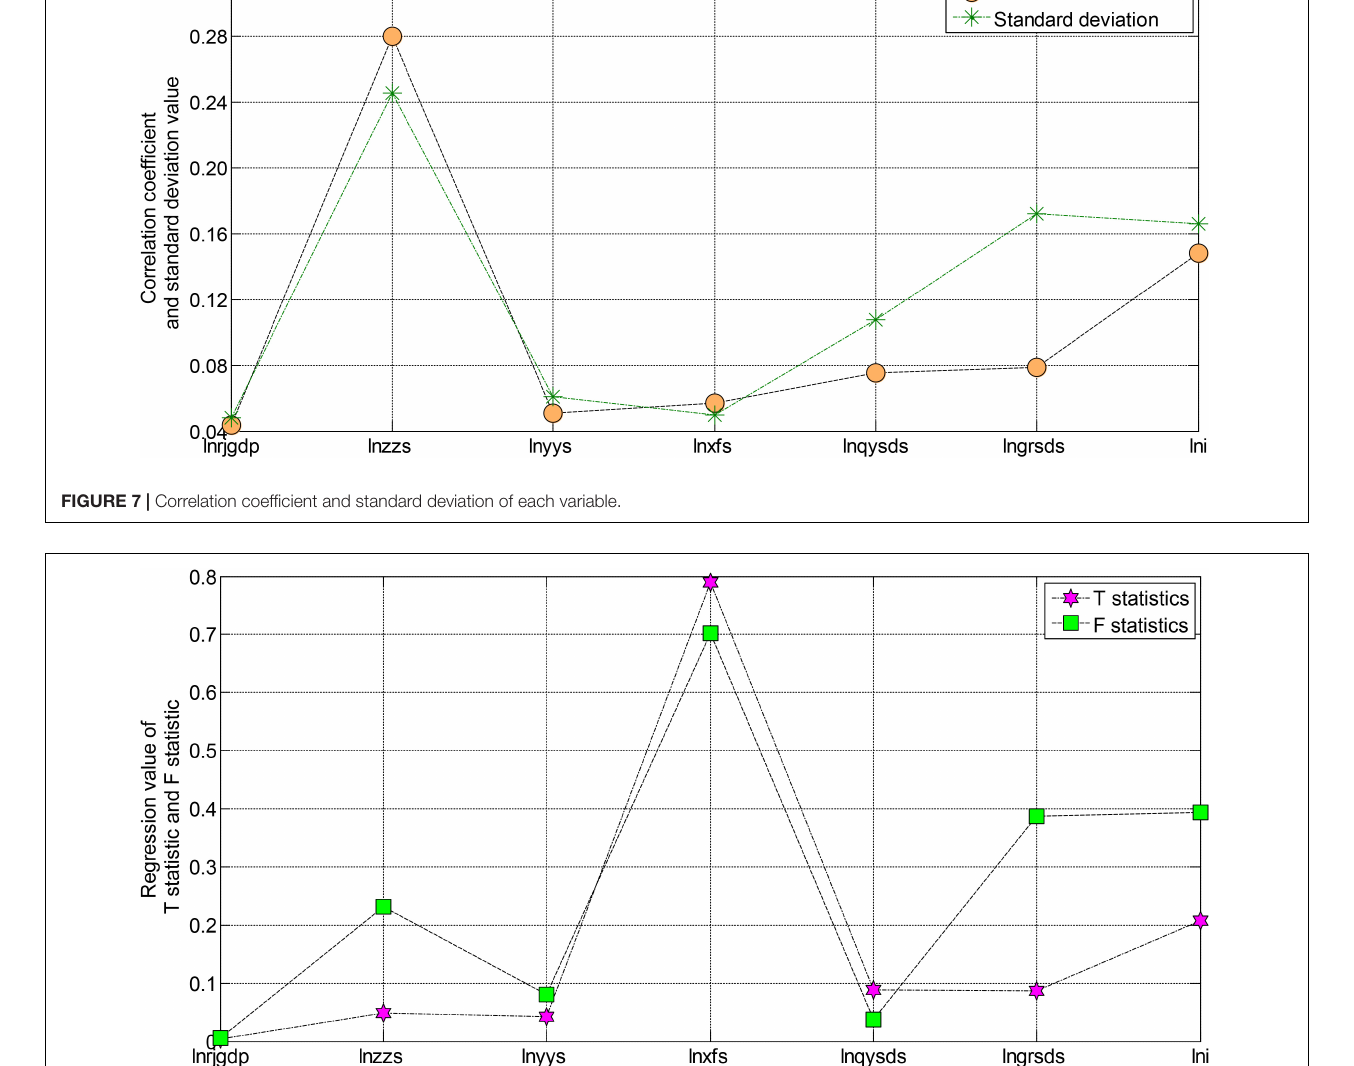
FIGURE 8 | The regression results of the T statistic and F statistic of each variable of the